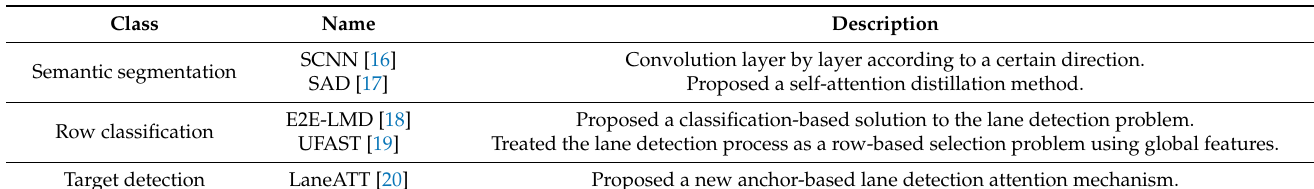
Table 3. The description of three different lane detection